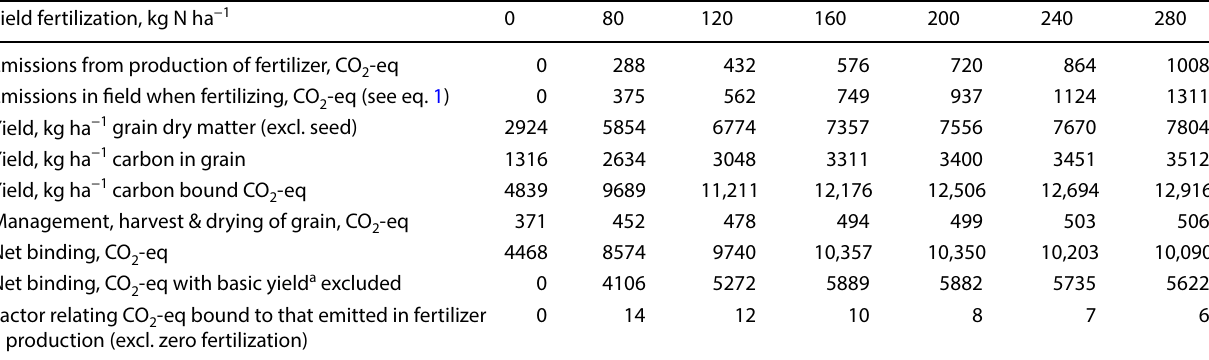
Table 3 Emissions of greenhouse gases (GHG), carbon content in grain, and estimated net binding of CO in field trials with winter wheat in southern Sweden